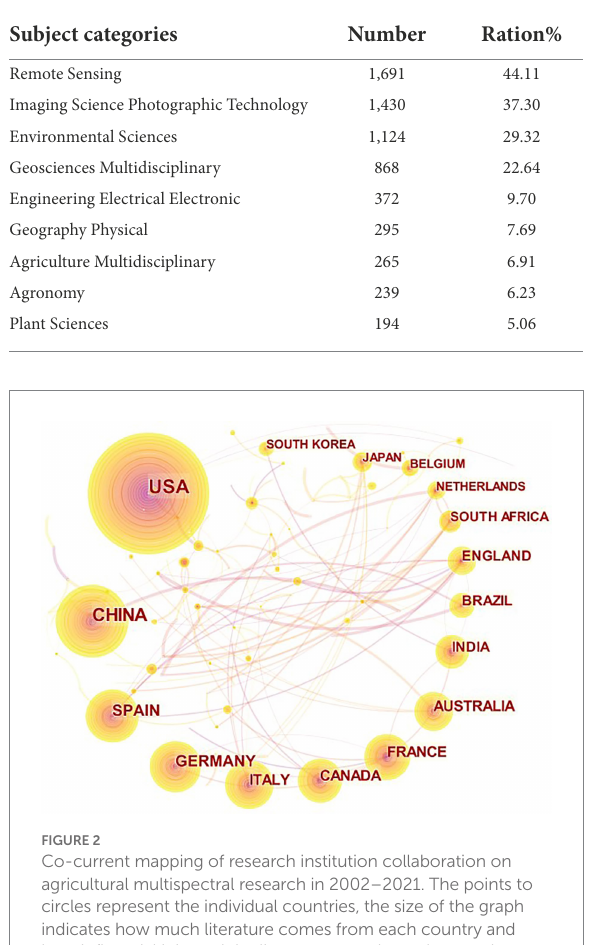
TABLE 1 Main categories of multispectral research literature in agriculture from 2002 to 2021.